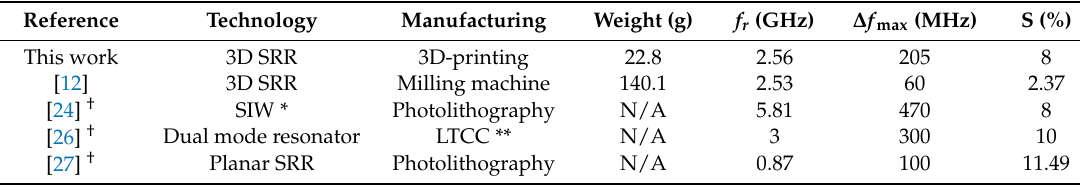
Table 3. Performance comparison of recently published microwave chemical sensors utilizing various manufacturing